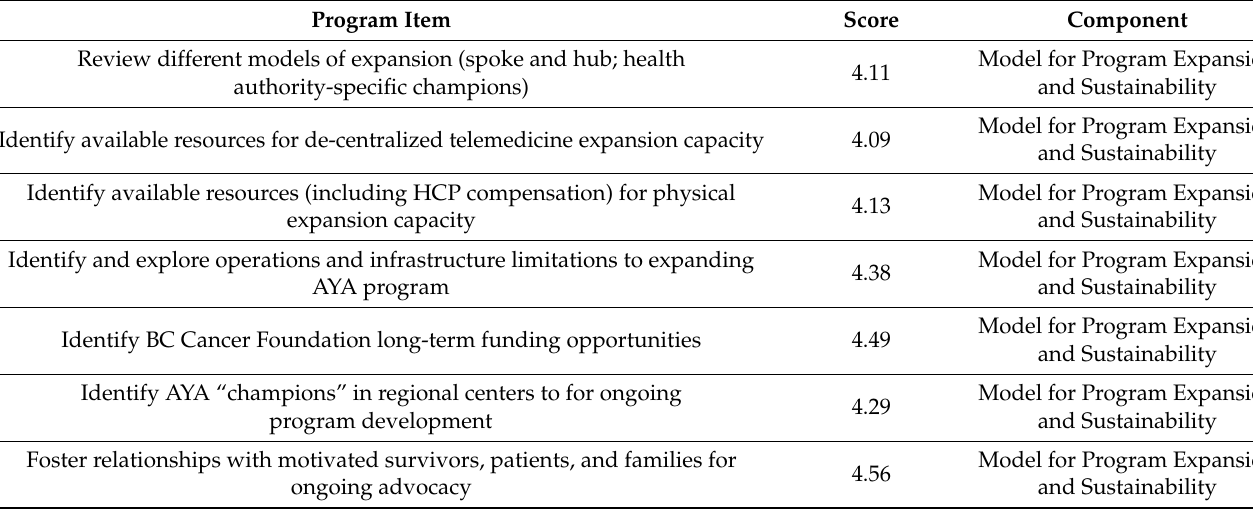
Table Discussion & Report Back: Program Mission & Goals